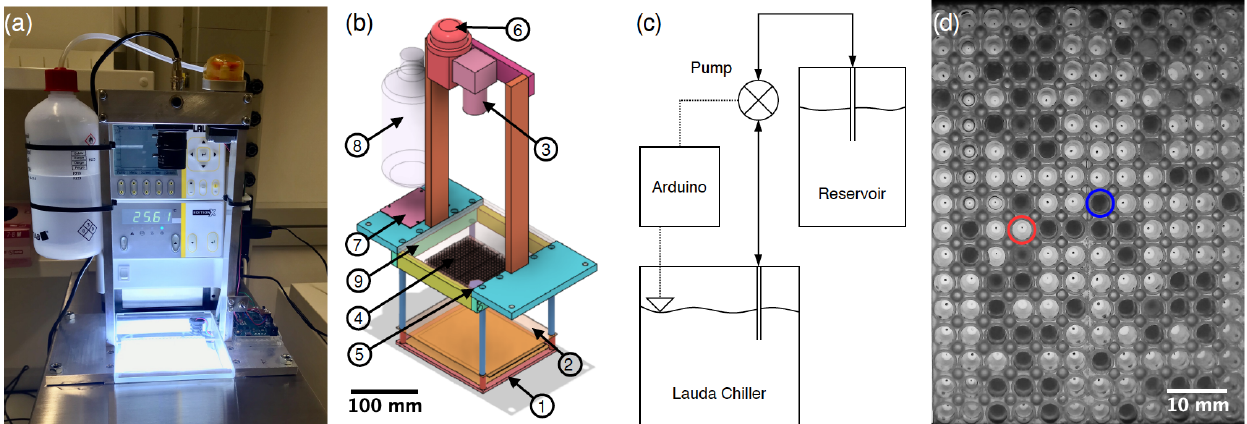
Figure 1. (a) Photograph of FINC. (b) Computer-aided design (CAD) software model of the aluminum and stainless-steel movable structure placed inside the LAUDA bath. The circled numbers correspond to the following parts: (1) a chip-on-board LED array, (2) a thin polytetraflu- oroethylene sheet, (3) a camera, (4) three clear polypropylene Piko™ PCR trays, (5) a level sensor, (6) a peristaltic pump, (7) an Arduino board and a stepper motor driver, (8) an ethanol reservoir, and (9) a Plexiglas plate. (c) Flowchart of the bath leveler setup. (d) Image of two of the three trays taken by the FINC camera showing the difference in light intensity between the liquid (circled in red) and frozen (circled in blue) wells used for freezing temperature